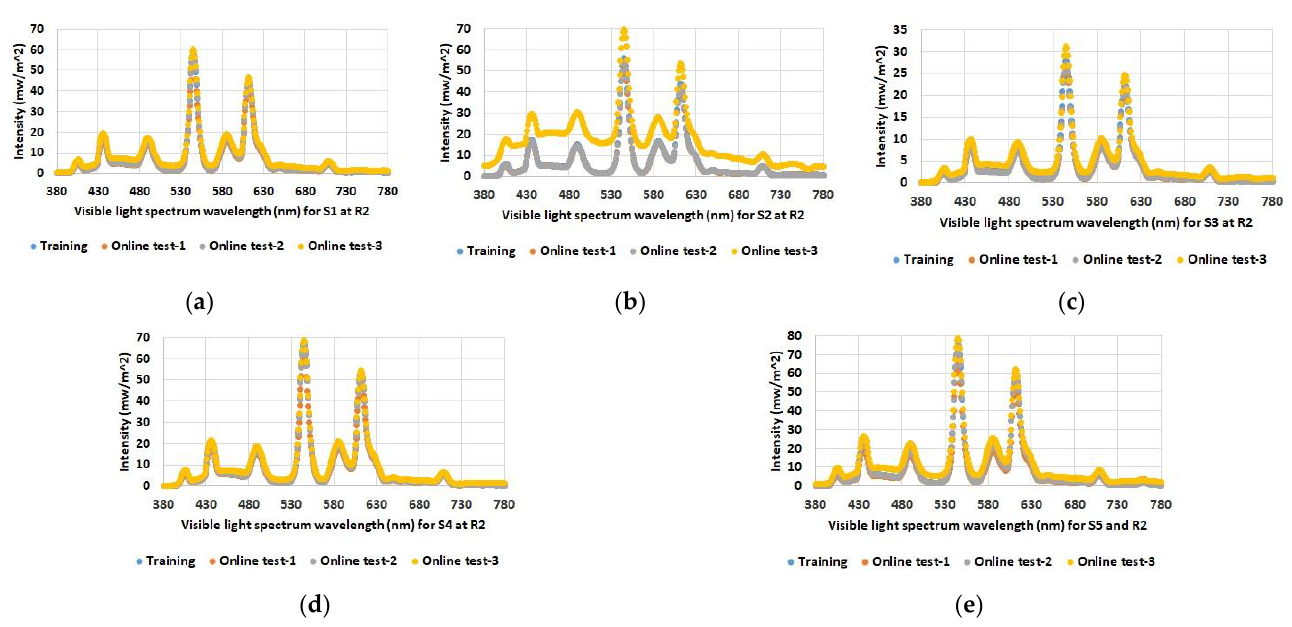
Figure 6. Determined spectral light distribution at defined spectrum test points in room 2: ( a ) S1; ( b ) S2; ( c ) S3; ( d ) S4; ( e ) S5.